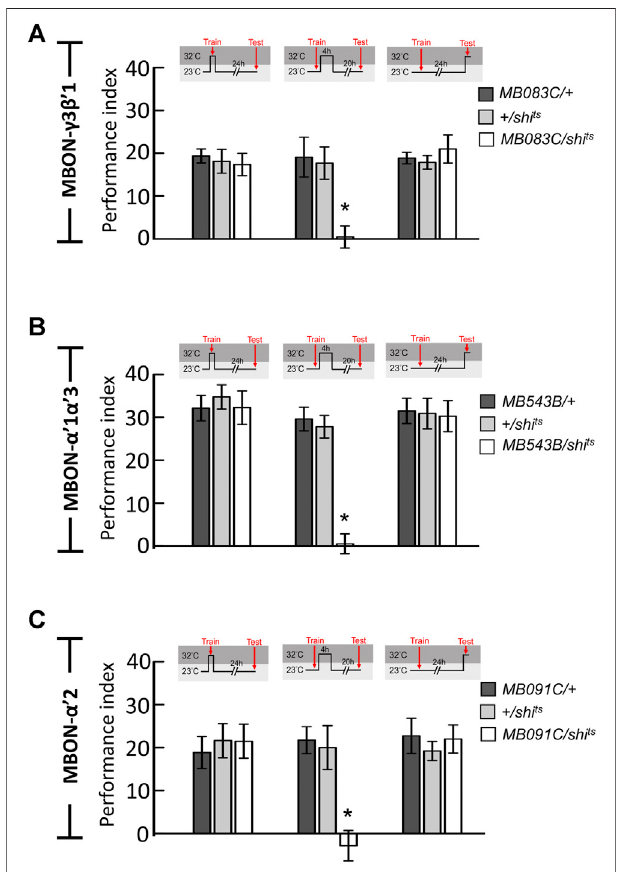
FIGURE 2 | Neurotransmission in MBON- γ 3 β ′ 1, MBON- α ′ 1 α ′ 3, and MBON- α ′ 2 is speci fi cally required for wLTM consolidation but not acquisition or retrieval. (A) Blocking neurotransmission in MBON- γ 3 β ′ 1 ( MB083C-GAL4 ) via shi ts during memory consolidation, but not during acquisition and retrieval,disruptedwLTM.Eachvaluerepresentsmean ± SEM(N (cid:1) 8,9,8,11, 14, 13,8,8,and 7fromlefttorightbars). * p < 0.05; one-wayANOVA followed by Tukey ’ s test. (B) Blocking neurotransmission in MBON- α ′ 1 α ′ 3 ( MB543B- GAL4 ) via shi ts during memory consolidation, but not during acquisition and retrieval,disruptedwLTM.Eachvaluerepresentsmean ± SEM(N (cid:1) 8,8,8,10, 10, 8, 8, 8, and 8 from left to right bars). * p < 0.05; one-way ANOVA followed by Tukey ’ s test. (C) Blocking neurotransmission in MBON- α ′ 2 ( MB091C- GAL4 ) via shi ts during memory consolidation, but not during acquisition and retrieval, disrupted wLTM (N (cid:1) 8,11,8, 8,11,13,8, 9,and 10fromleft